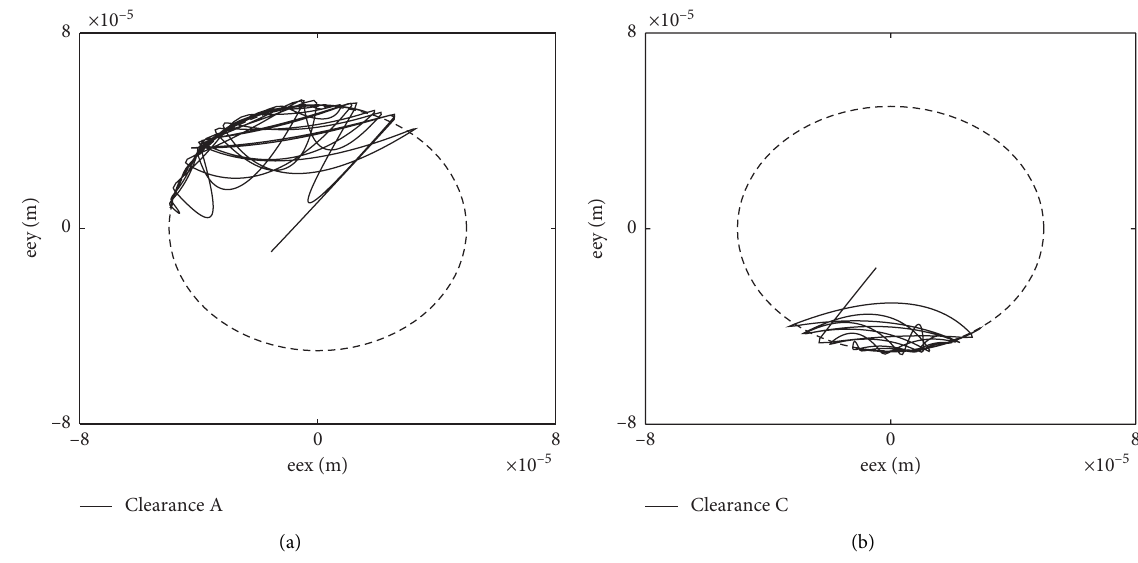
Figure 8: Shaft center motion trajectory at (a) clearance A and (b) clearance